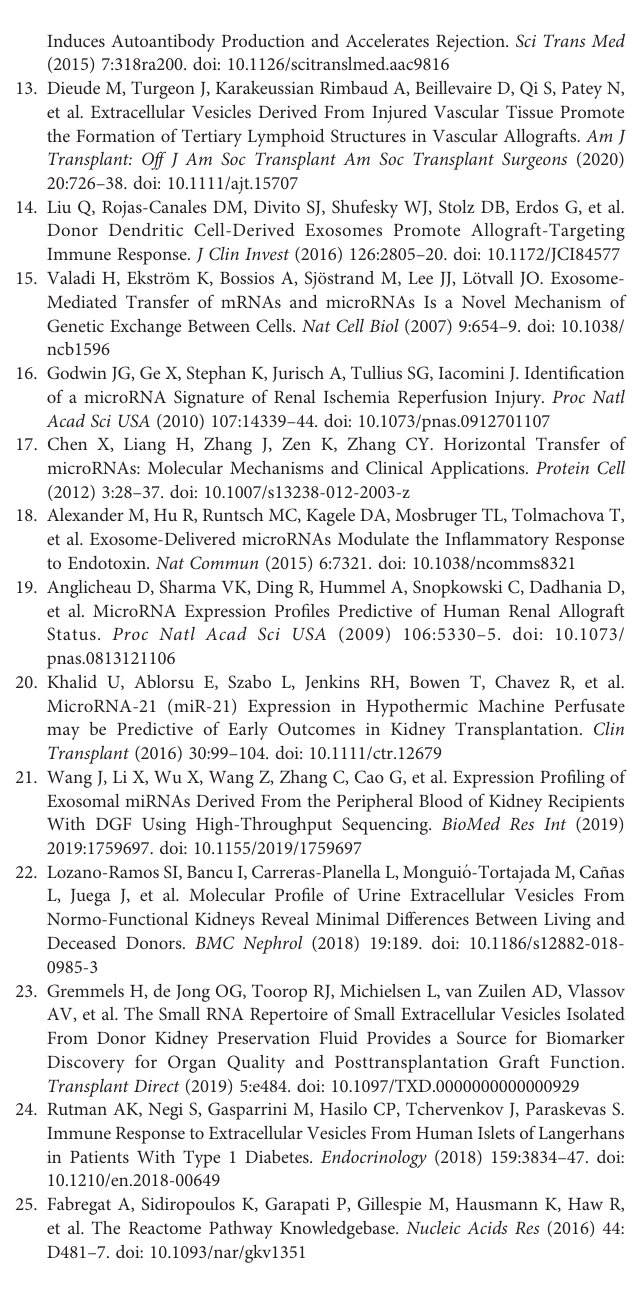
Supplementary Figure 3 | Expression of miR-675-5p in KP-EV correlations with recipient eGFR. (A – F) Correlation of KP-EV miR-675-5p expression levels as measured by miRNA sequencing with respective recipient eGFR at (A) day 7 (B) day 14 (C) day 30 (D) day 90 (E) day 180 and (F) day 360 following transplantation. Supplementary Figure 4 | Expression of miR-218-5p in KP-EV correlations with donor parameters. (A – D) Correlation of KP-EV miR-218-5p expression levels as measured by miRNA sequencing with (A) cold ischemic time (B) pump time (C) donor eGFR and (D) donor